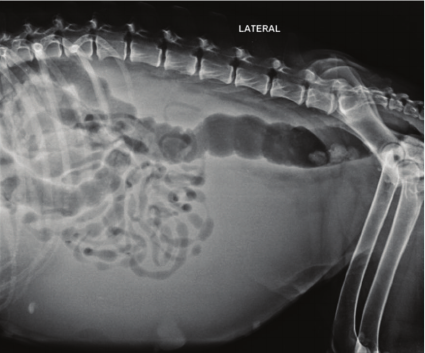
Figure 4: X-ray of abdomen showing ground glass appearance indicating free fluid in abdominal